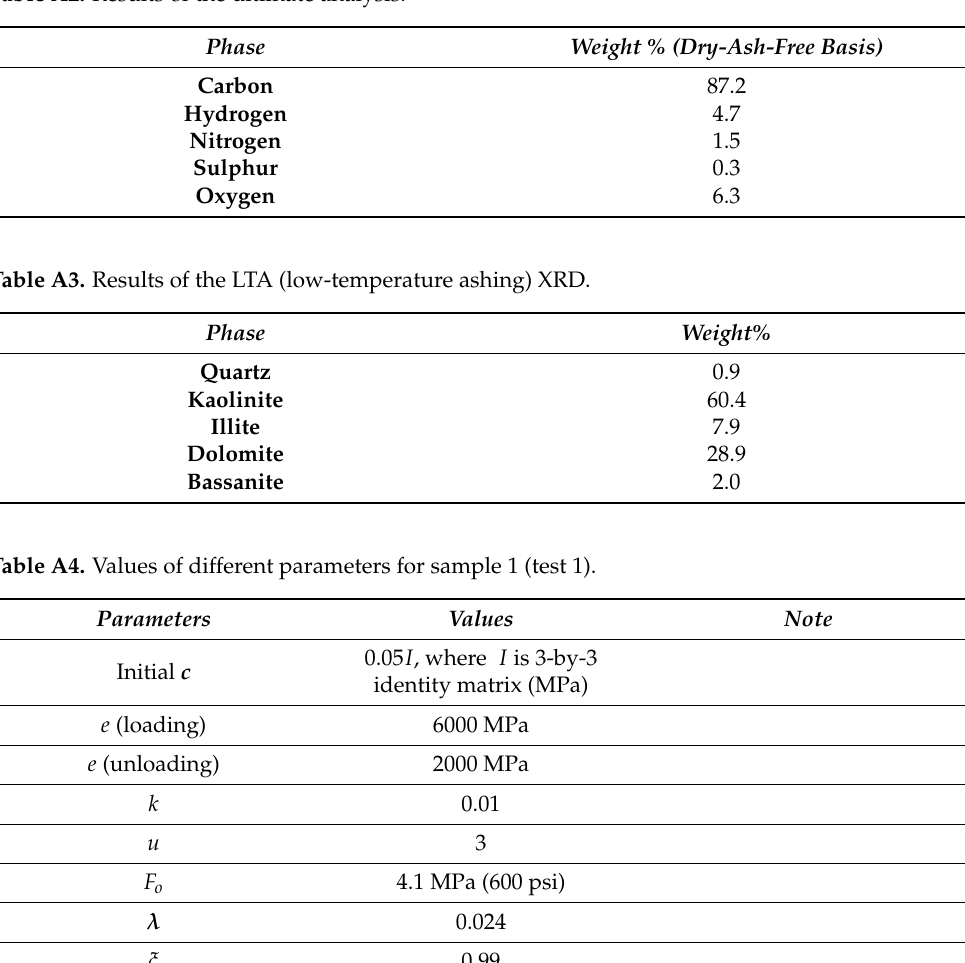
Table A2. Results of the ultimate analysis.